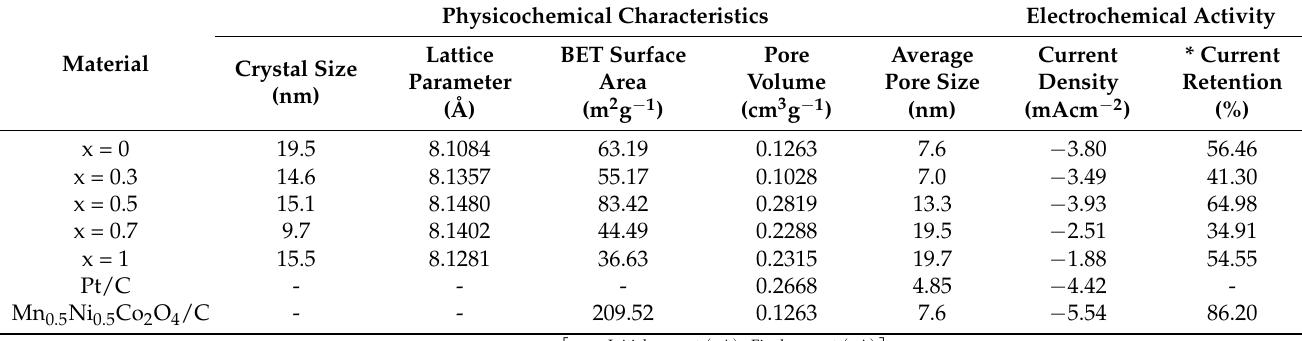
Figure 1. ( a ) XRD patterns of Mn x Ni 1 − x Co 2 O 4 (x = 0, 0.3, 0.5, 0.7, and 1); ( b ) XRD patterns of Mn 0.5 Ni 0.5 Co 2 O 4 /C and Mn 0.5 Ni 0.5 Co 2 O 4 . Table 1. The structural and electrochemical characteristics of the synthesized electrocatalysts.